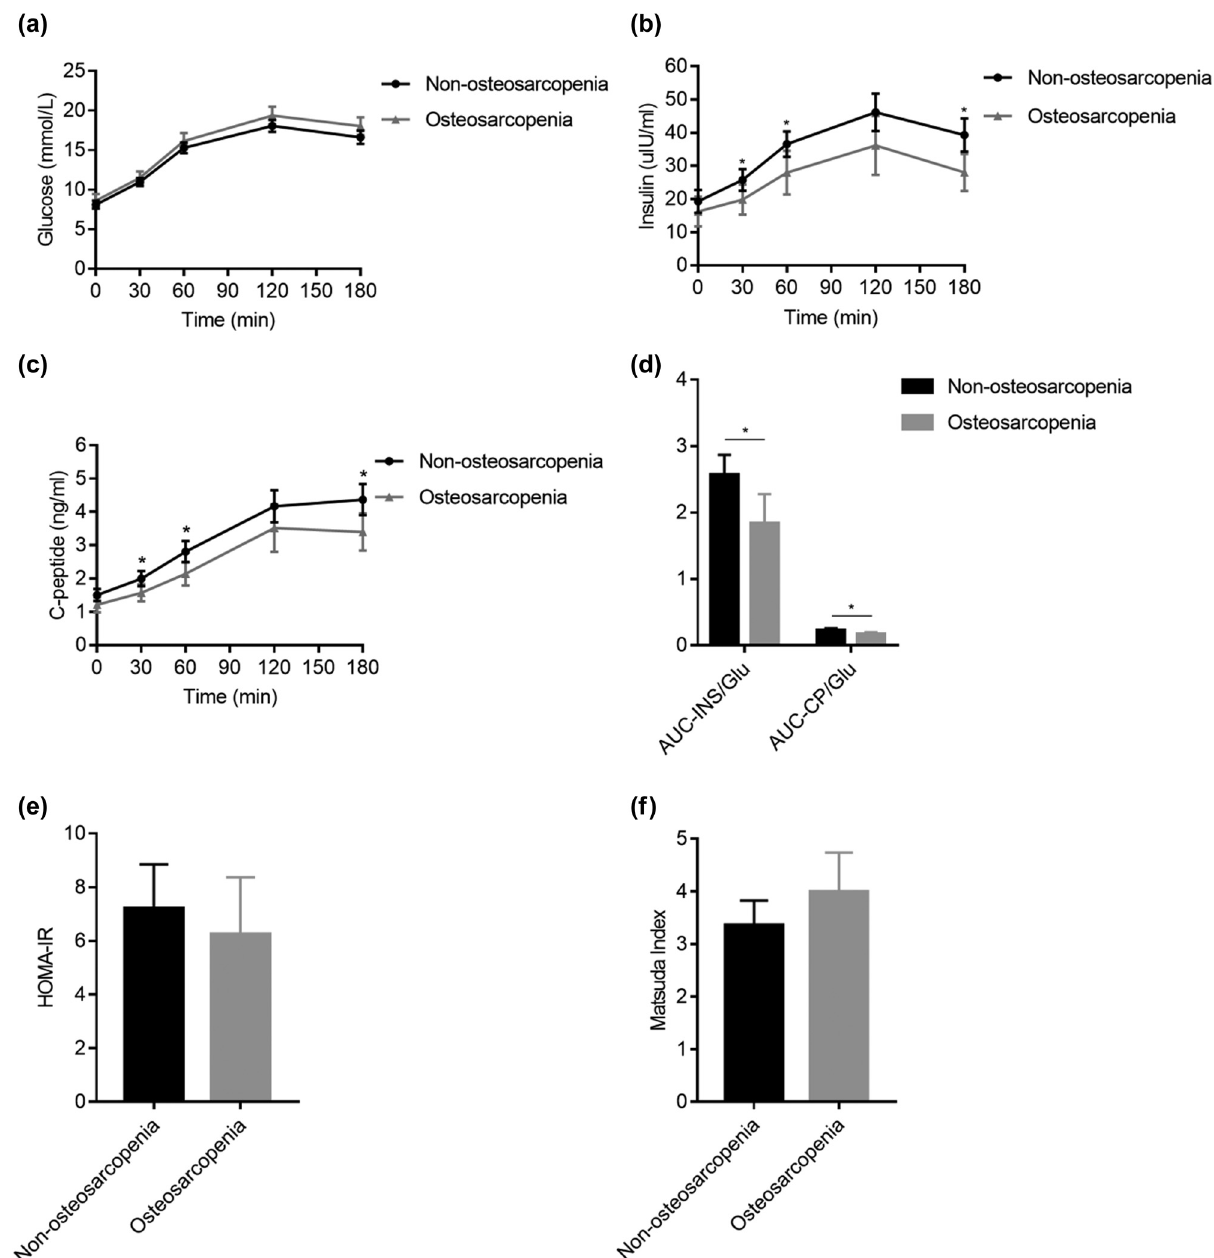
Figure 1: Comparison of the levels of OGTT - induced serum glucose, insulin, C peptide, β - cell function, and insulin resistance status of the two groups. ( a – c ) Serum glucose ( a ) , insulin ( b ) , and C - peptide ( c ) during 180 min OGTT. ( d ) β - Cell function measured by AUC - Ins/Glu and AUC - CP/Glu. ( e – f ) Insulin resistance status measured by HOMA - IR ( e ) and Matsuda index ( f ) . Each error bar is constructed using a 95% con fi dence interval of the mean. * P < 0.05 versus